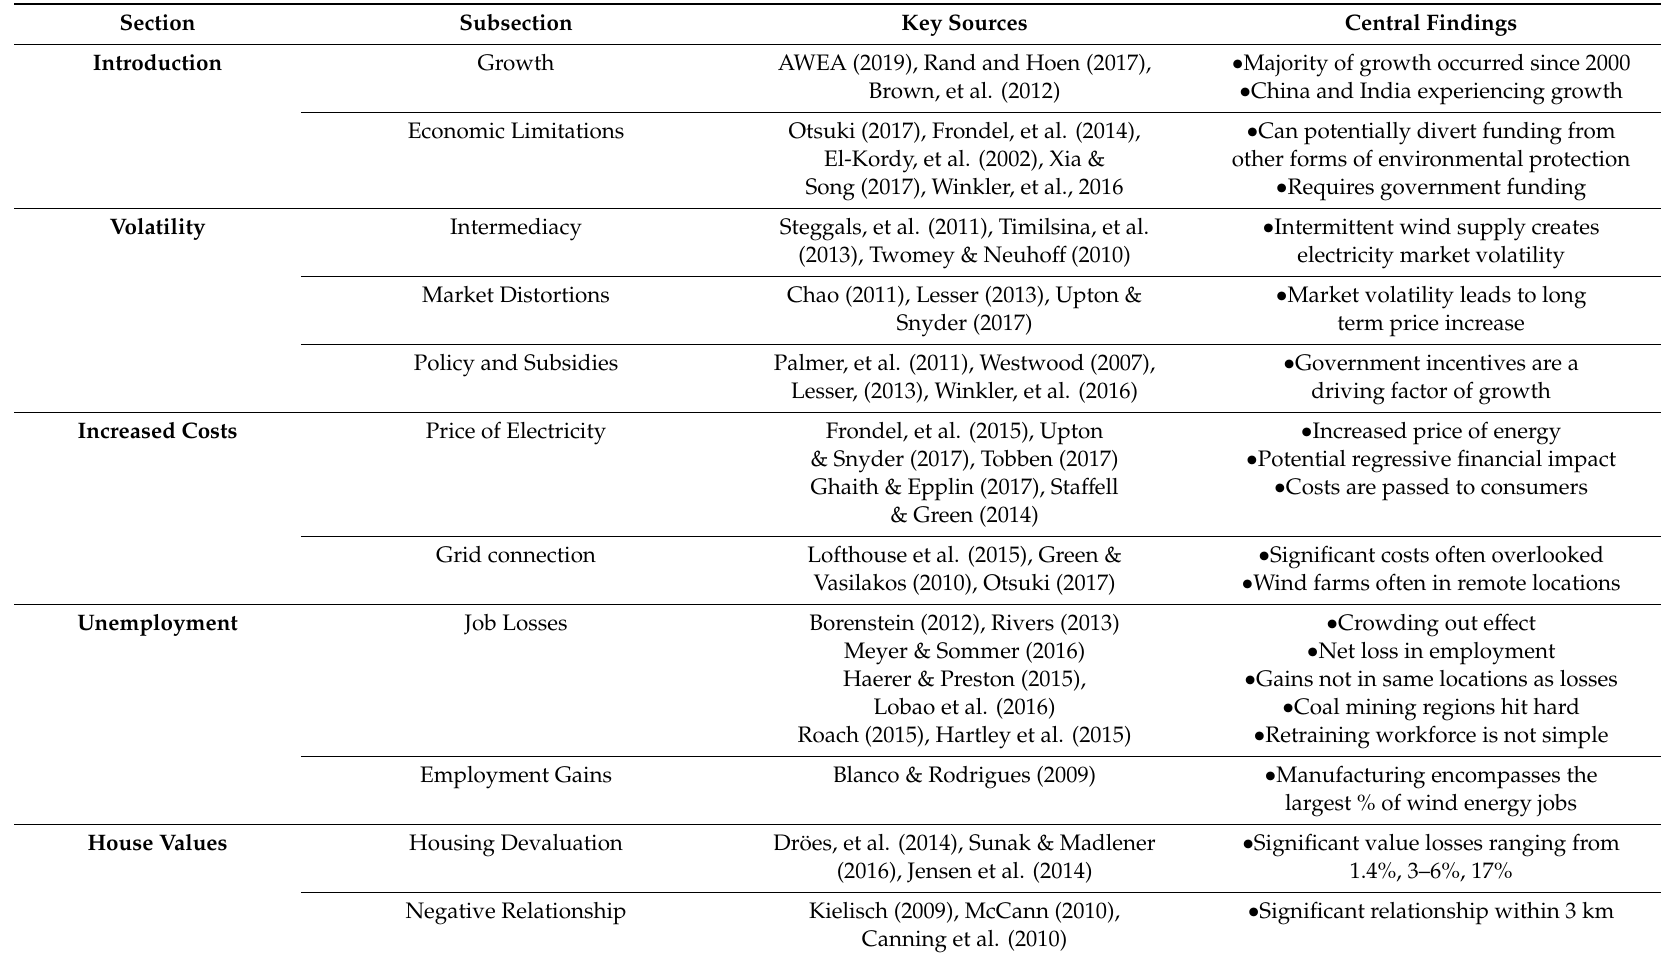
Table 1. Summary of